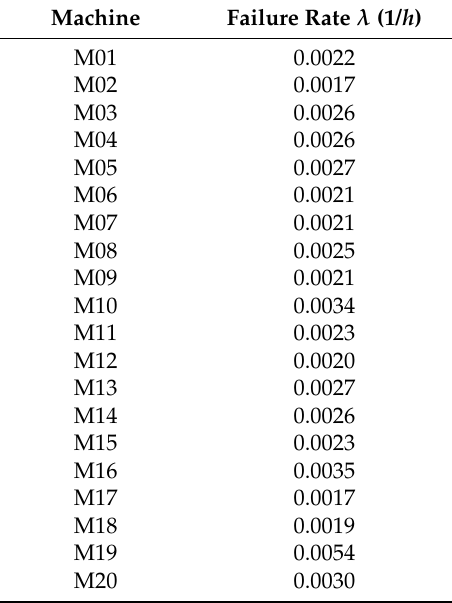
Table 1. The failure rate of each machine.